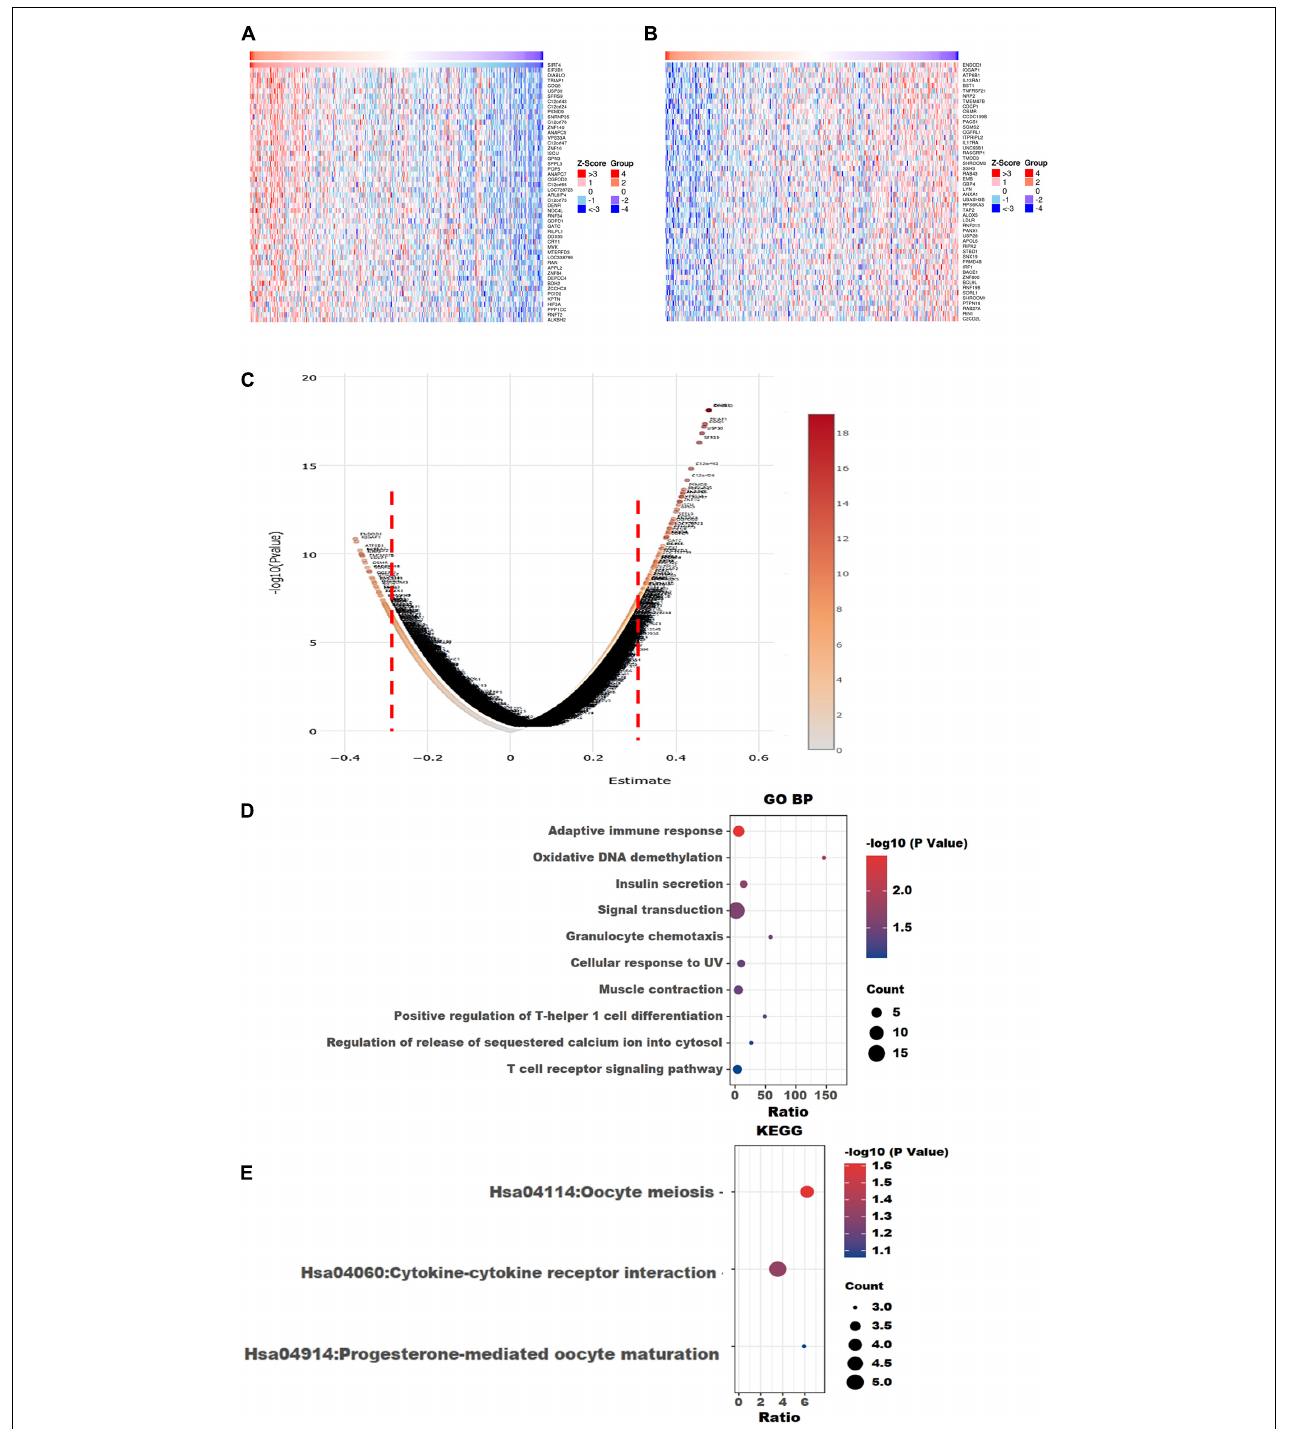
FIGURE 8 | Visualization of Gene Ontology (GO) and Kyoto Encyclopedia of Genes and Genomes (KEGG) enrichment analyses for the SIRT4-correlated genes from The Cancer Genome Atlas ovarian cancer (TCGA-OV). (A) Heatmap of the top 50 positively correlated genes of SIRT4 from TCGA-OV after normalization. (B) Heatmap of the top 50 negatively correlated genes of SIRT4 from TCGA-OV after normalization. Red indicates cases with higher expression and blue indicates cases with lower expression ( Z -score). (C) Volcano plot of all correlated genes of SIRT4 in TCGA-OV, as determined using Pearson’s correlation test. X -axis is the correlation coefficient. Red dotted line indicates the cutoff value for GO and KEGG analyses. (D) Top 10 terms of GO BP (biological process) enrichment analysis of the selected genes with Pearson’s correlation > | 0.3| for SIRT4. (E) KEGG enrichment analysis using genes as per Pearson’s correlation test. The p -value was calculated and sorted with − log 10 ( P ). Dark red indicates the lowest p